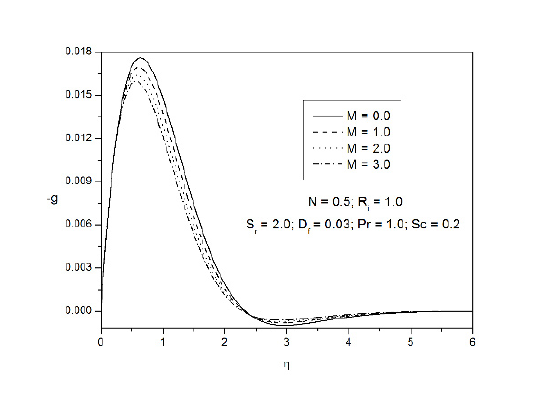
Figure 2. Microrotation profile for various values of Magnetic param- eter